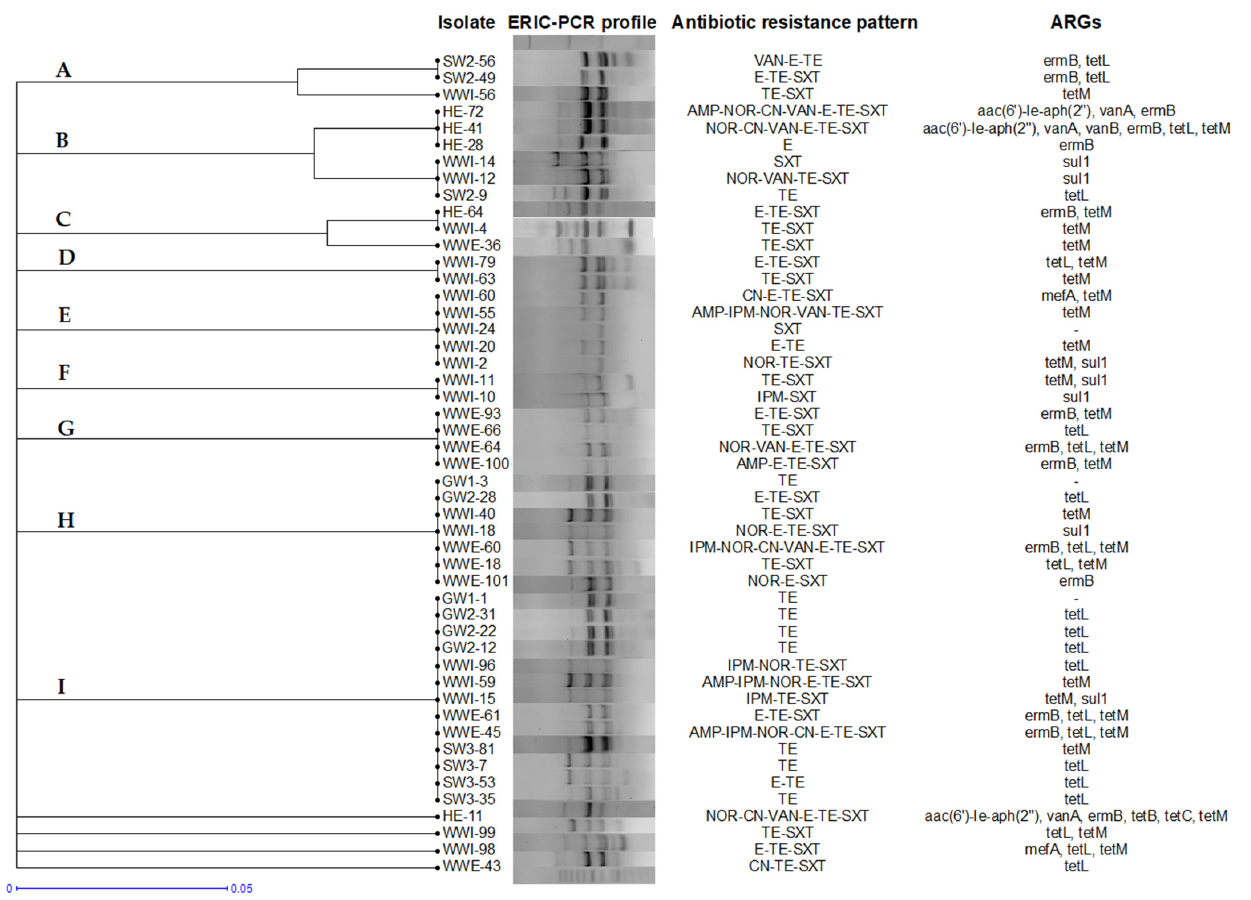
Figure 4. ERIC-PCR dendrogram and antibiotic resistance profiles of E. faecalis isolates. The isolates were labelled by sources: GW = groundwater; HE = hospital effluent; SW = surface water; WWI = wastewater influent; WWE = wastewater effluent.